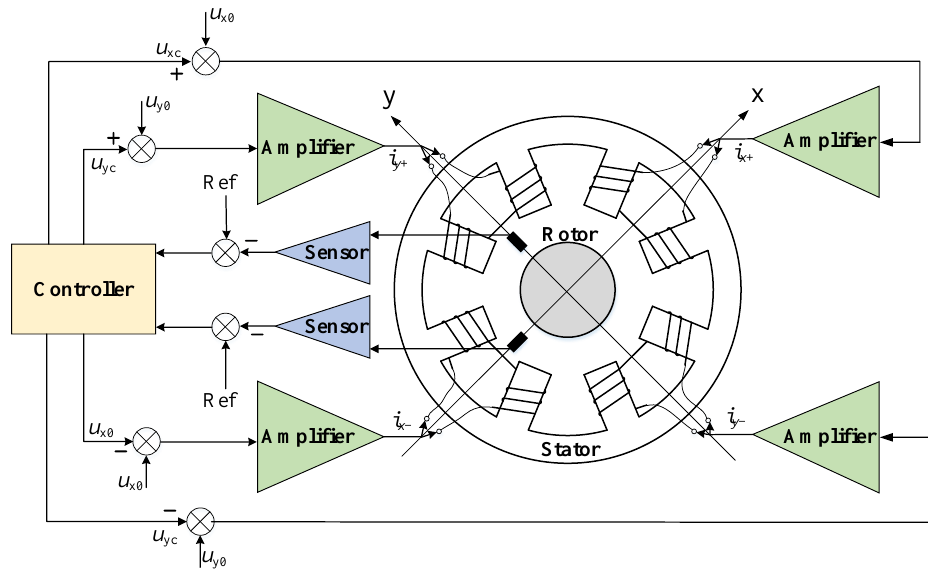
Figure 2. Basic principle of a radial AMB .